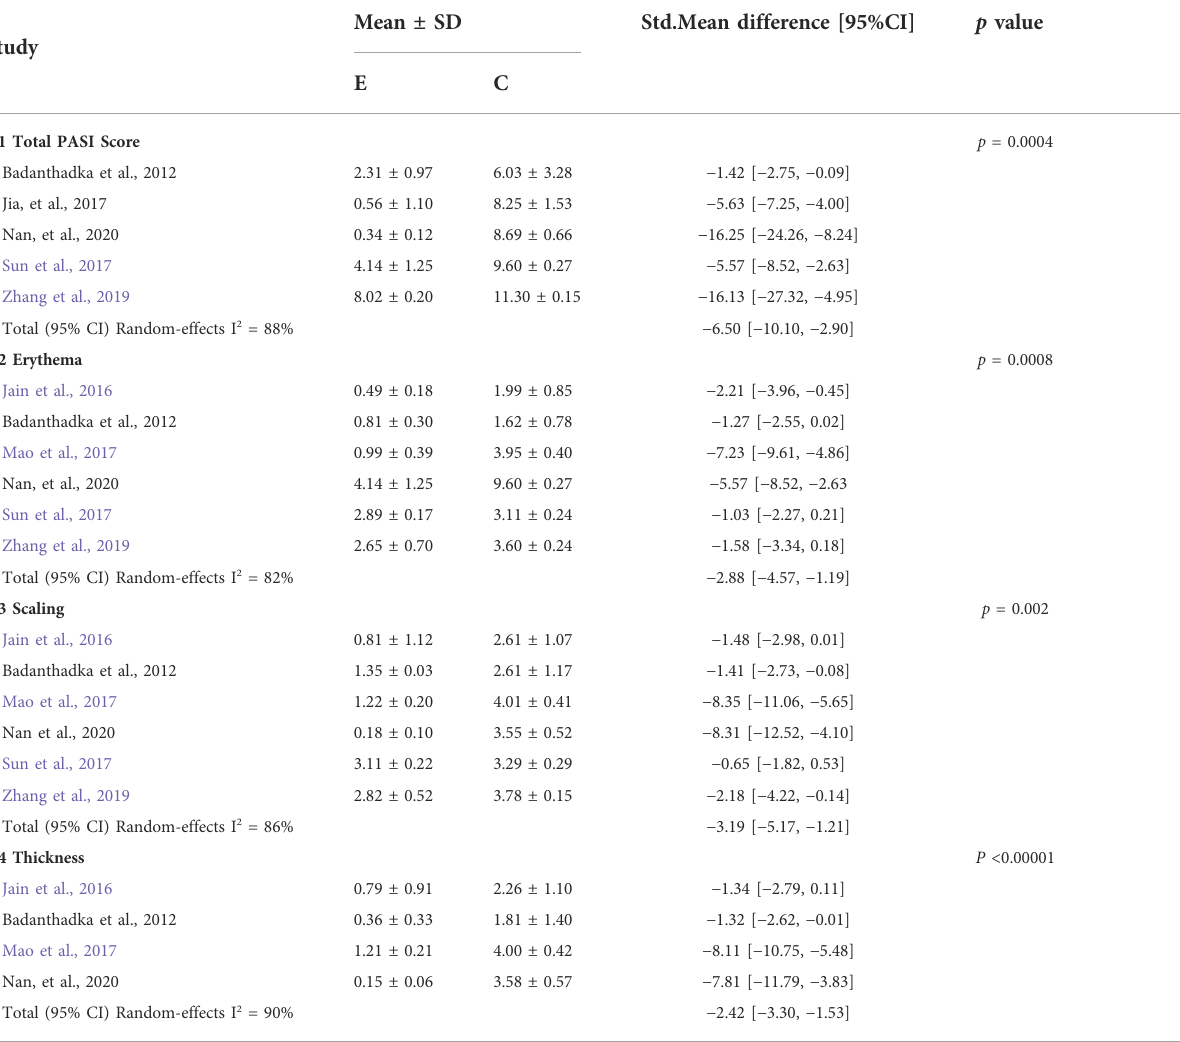
TABLE 3 Analysis of PASI scores in preclinical studies in vivo.